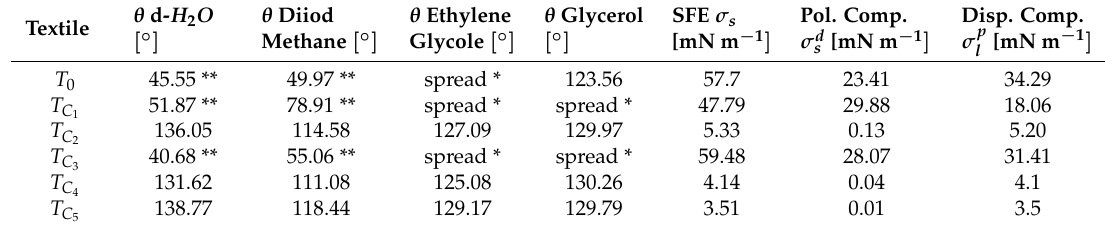
Table 6. Measured contact angles and calculated surface energies and their components by the